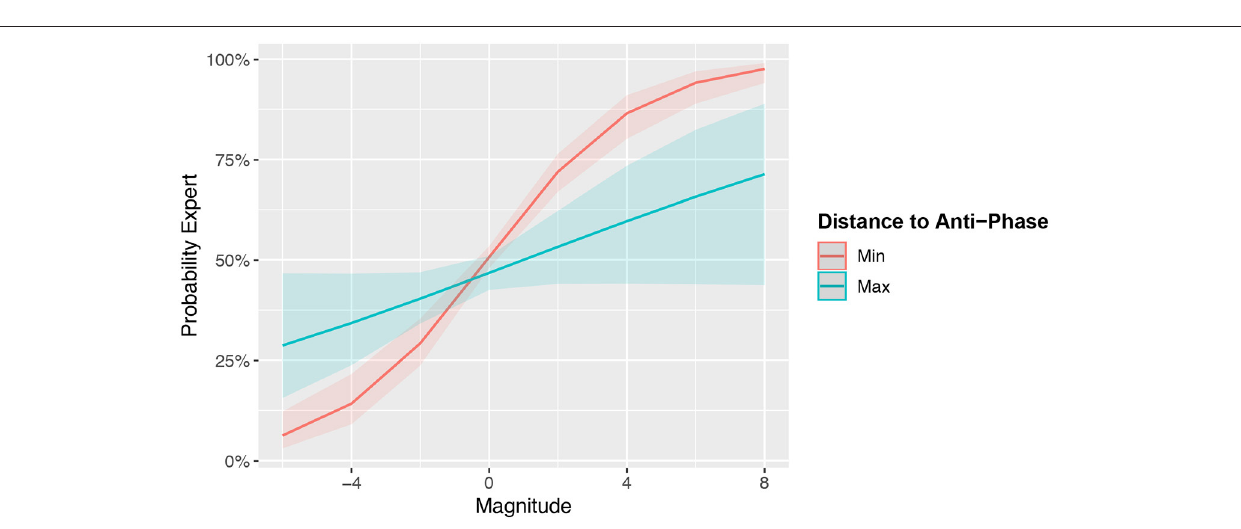
This motion pattern is less energetically expensive, more efficient and may lead to improved performance and